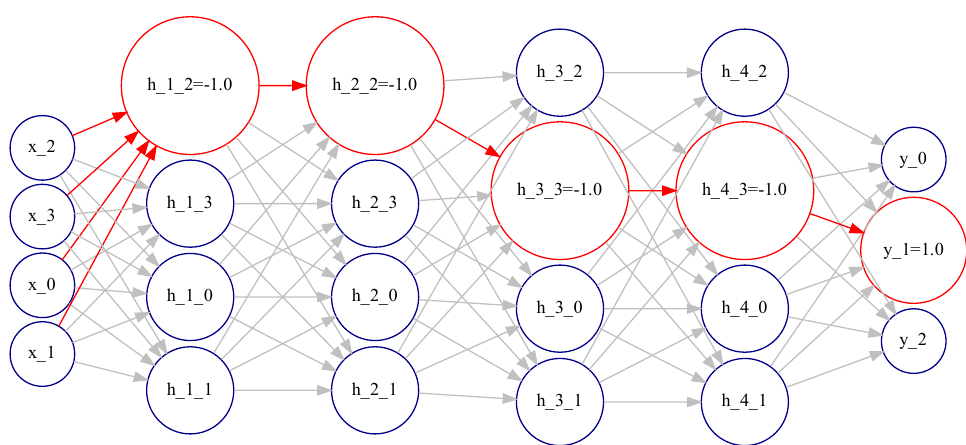
Figure 5. The activation pattern (the most frequently activated neurons) for class 1 is highlighted in red over the DL predictor architecture (Iris dataset). In addition, the most frequent activation values are shown for neurons in the activation pattern.